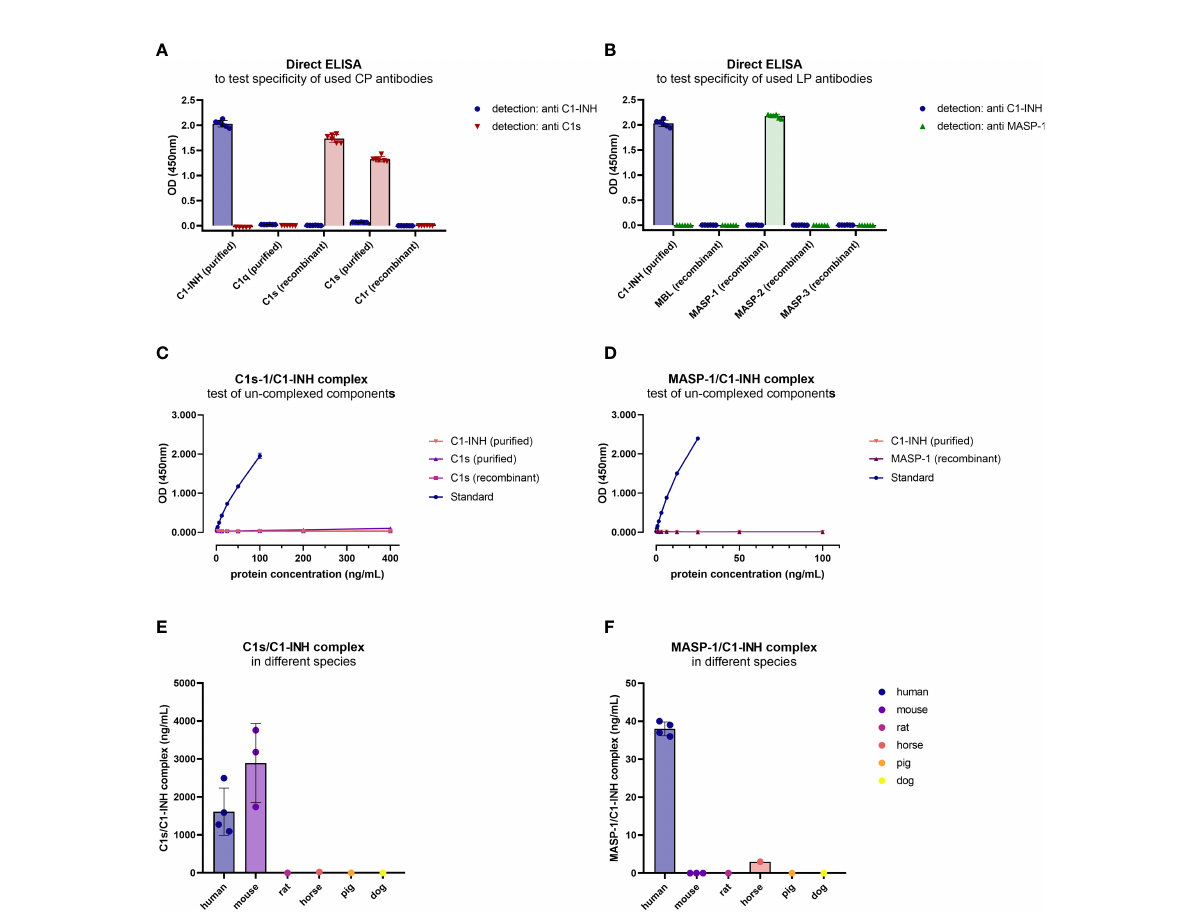
FIGURE 4 Cross-reactivity of antibodies and new immunoassays. (A, B) Binding of antibodies to proteins of the respective pathways was tested in a direct ELISA. For classical pathway proteins, detection was done with either the C1-INH or C1s antibody, while for lectin pathway proteins detection was done with the C1-INH and MASP-1 antibodies also used during assay development. Conditions were tested in duplicates, while the experiment was performed in triplicates. (C, D) Cross-reactivity of un-complexed complement components was tested using either puri fi ed or recombinant proteins of the complex, dependent on availability. While C1s (puri fi ed and recombinant) and C1-INH (puri fi ed) were tested in the C1s/C1-INH complex assay (C) , MASP-1 (recombinant) and C1-INH (puri fi ed) were measured in the MASP-1/C1-INH assay (D) . (E, F) Cross- reactivity of serum samples from animal origin was investigated in the assays using human EDTA plasma samples (n=4) as a reference, murine serum (n=3), rat serum (n=1), horse serum (n=1), pig serum (n=1) and dog serum (n=1) ( E : C1s/C1-INH complex, F : MASP-1/C1-INH complex). Animal samples were measured 10x less diluted compared to human samples. OD, optical density; nm,